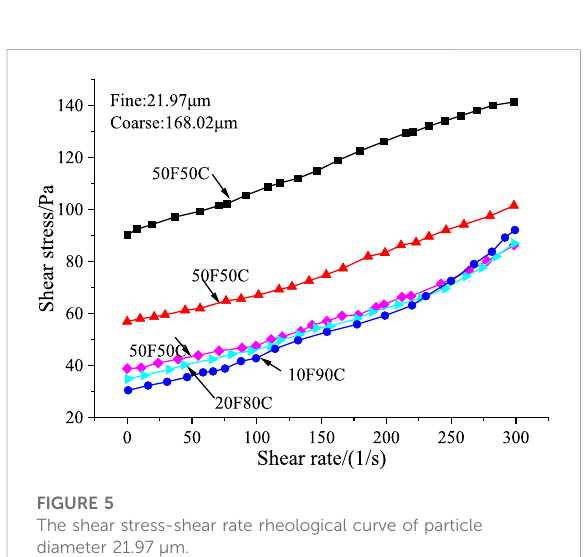
FIGURE 4 The shear stress-shear rate rheological curve of particle diameter 10.21 μ m.